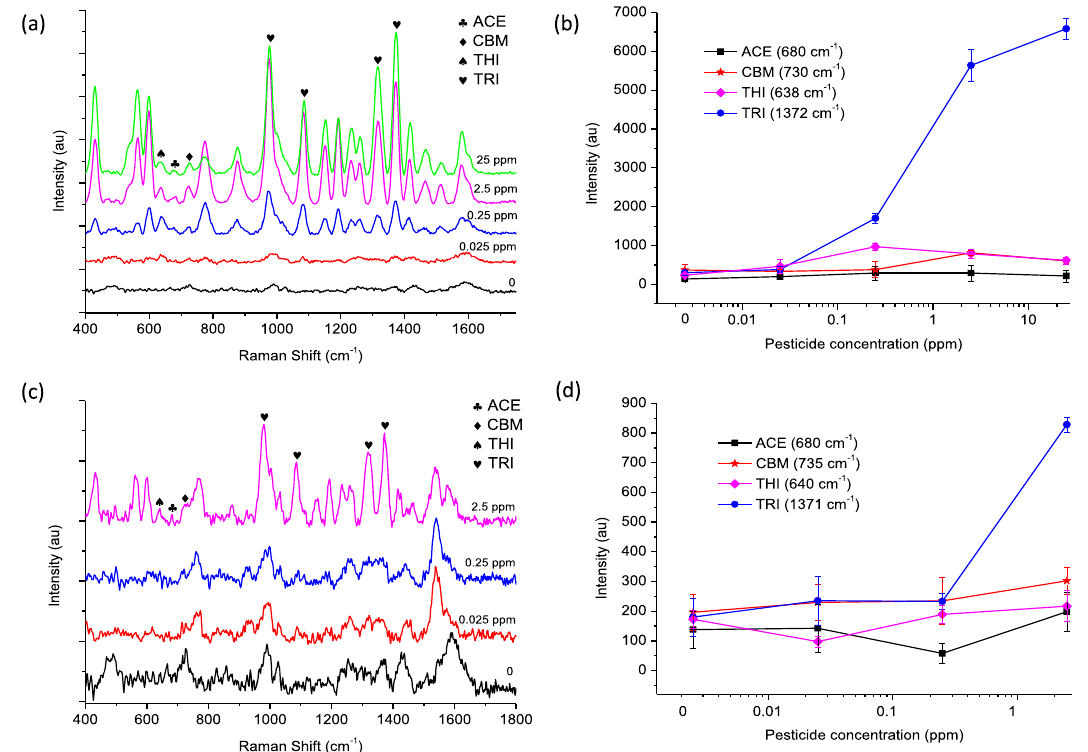
Fig. 7 Analysis of mixed pesticide residues (ACE, CBM, THI and TRI at equal concentrations) using handheld-SERS. a SERS spectrum for mixed pesticide residues analysed in solvent. b Identi fi ed spectral features and corresponding SERS intensity for individual pesticide residues in solvent. c SERS spectrum for mixed pesticide residues extracted from spiked basmati rice. d Identi fi ed spectral features and corresponding SERS intensity for individual pesticide residues extracted from spiked basmati